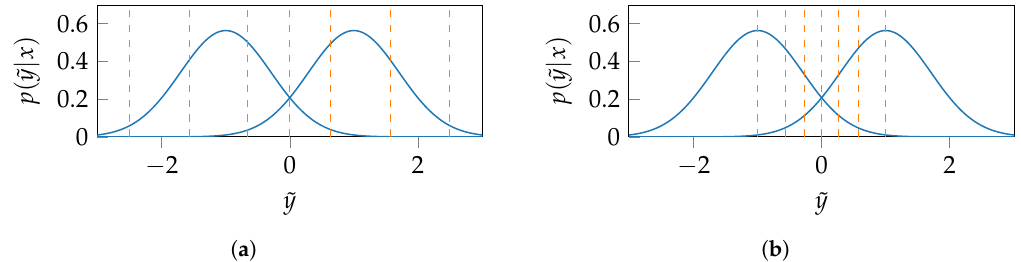
Figure 4. Transition probability of AWGN channel where continuous channel output ˜ y is clustered = 0.5. ( a ) Randomly initialized symmetric cluster boundaries. into |Y| = 8 bins or clusters for σ 2 N ( b ) Cluster boundaries optimized such that I ( X ; Y ) is maximum for |Y| =